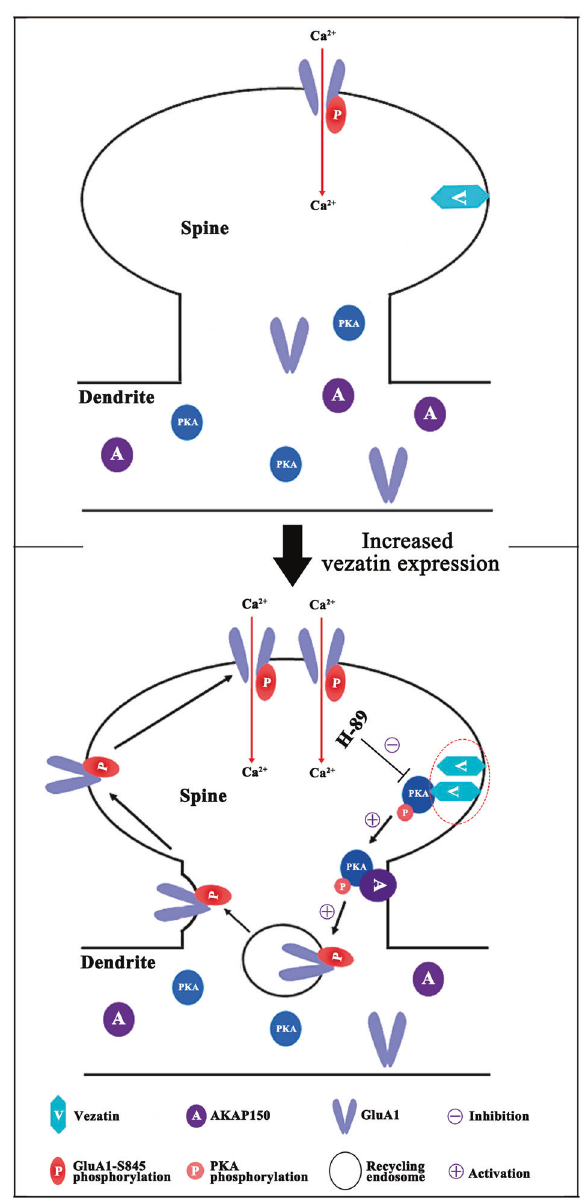
Fig. 8 Schematic of the mechanism by which vezatin regulates seizure activity. Increased vezatin expression promotes PKA activation (which can be blocked by H-89), facilitating the targeting of pGluA1-S845 by PKA and AKAP150, further increasing the phosphorylation of GluA1 at serine 845 and promoting the targeting of AMPARs to the neuronal surface and then to postsynaptic elements, ultimately enhancing AMPAR-mediated synaptic transmission and promoting seizure activity in individuals with 512 pixels resolution. Images of cultured neurons were obtained with a 60x oil immersion objective (numerical aperture: 1.4; working distance 0.13 mm, corrected for 0.17 mm coverslips) as z-series of ~6 – 8 images captured at 1 μ m intervals with an acquisition setting of a 1024 × 1024 pixels resolution. The quantitative analysis of immuno fl uorescence staining was eval- uated using Image-Pro Plus 6.0 software (Media Cybernetics). Images of vezatin immuno fl uorescence staining in the hippocampal CA1 region region was divided into three layers: stratum oriens, pyramidal cell layer,